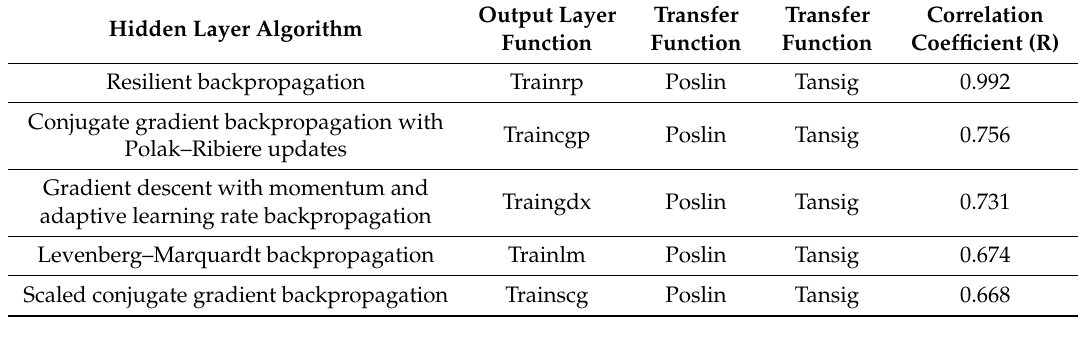
Table 3. Summary of algorithms employed in this present study.